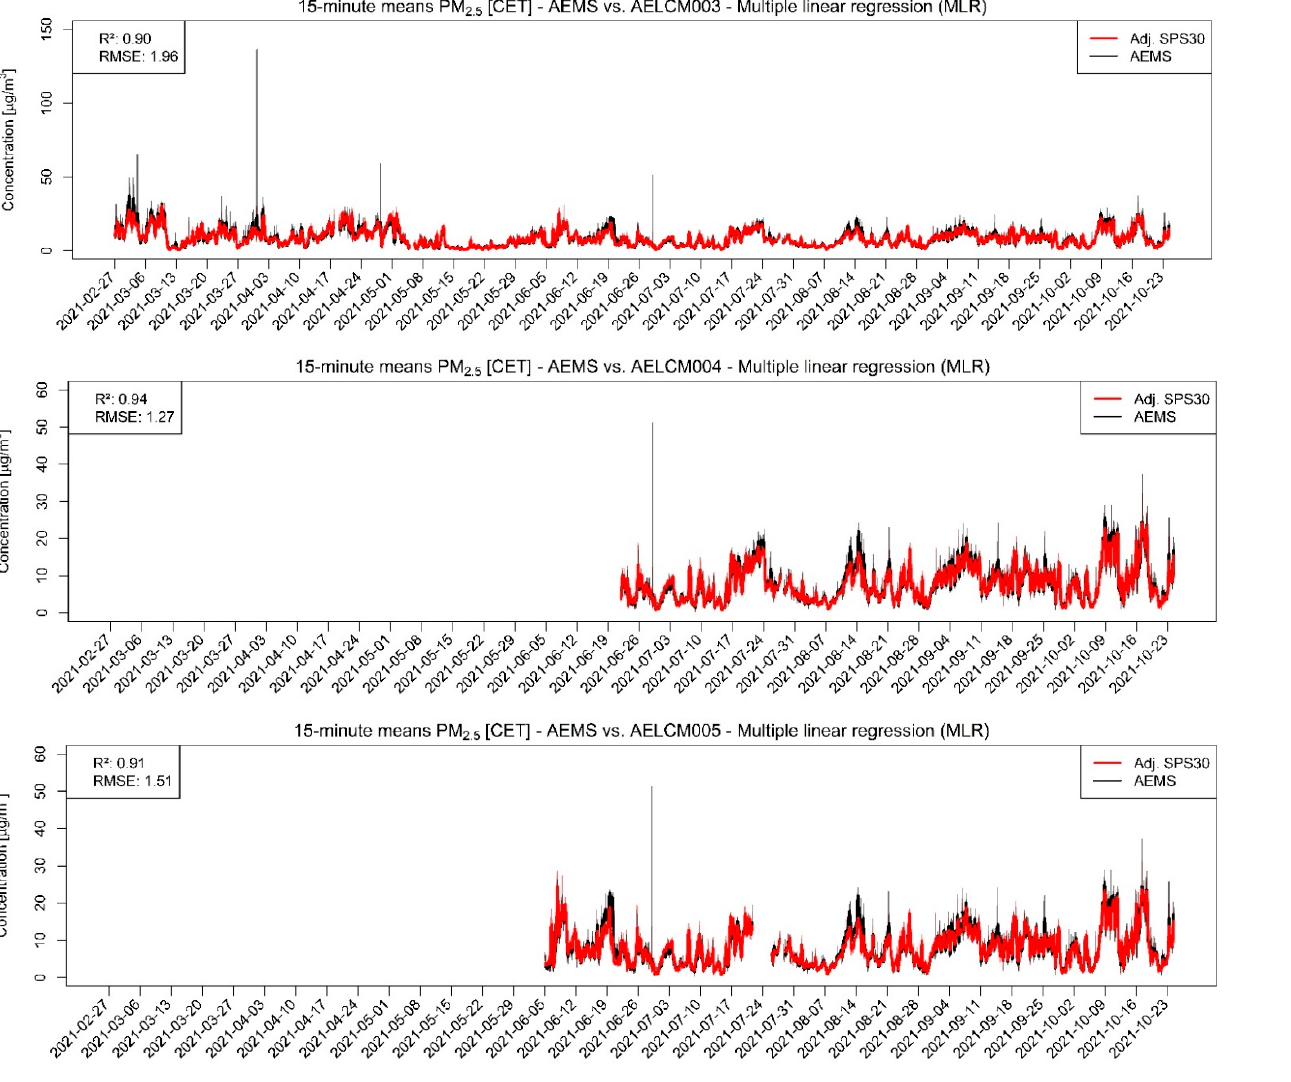
Figure 6. Model-adjusted 15 min concentration means of different deployed SPS30 using multiple linear regression vs. 15 min concentration means of reference measurements given by the AEMS for PM2.5 in µ g/m 3 . The RMSE is in µ g/m 3 . For smoothing the 15 min concentration means a rolling 24 h average is used: ( Top ) SPS30 deployed in AELCM003; ( Middle ) SPS30 deployed in AELCM004; and ( Bottom ) SPS30 deployed in AELCM005.